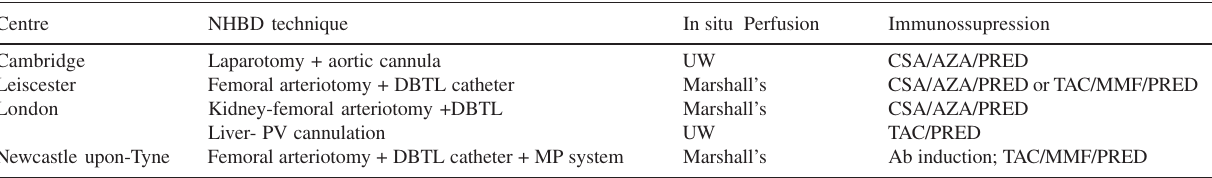
Table 10 - England centres and variations of non-heart-beating donors